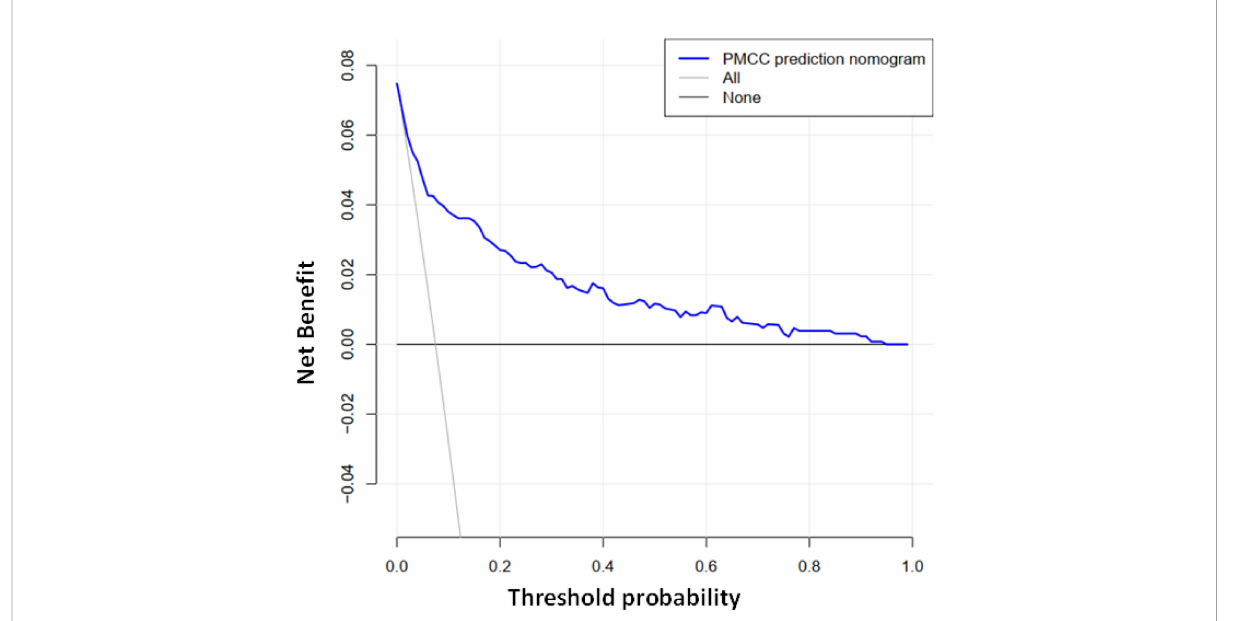
FIGURE 5 Decision curve analysis of the PMCC nomogram. The Y-axis represents the net bene fi t. The grey solid line represents the PMCC risk map. The black solid line signi fi es assumption of PMCC for all patients. The blue solid line indicates no PMCC assumption. DCA showed that under probability of PMCC threshold of 1 – 94%, using a nomogram to predict risk of PMCC was more bene fi cial than “ all patient intervention ” and “ non-intervention ”